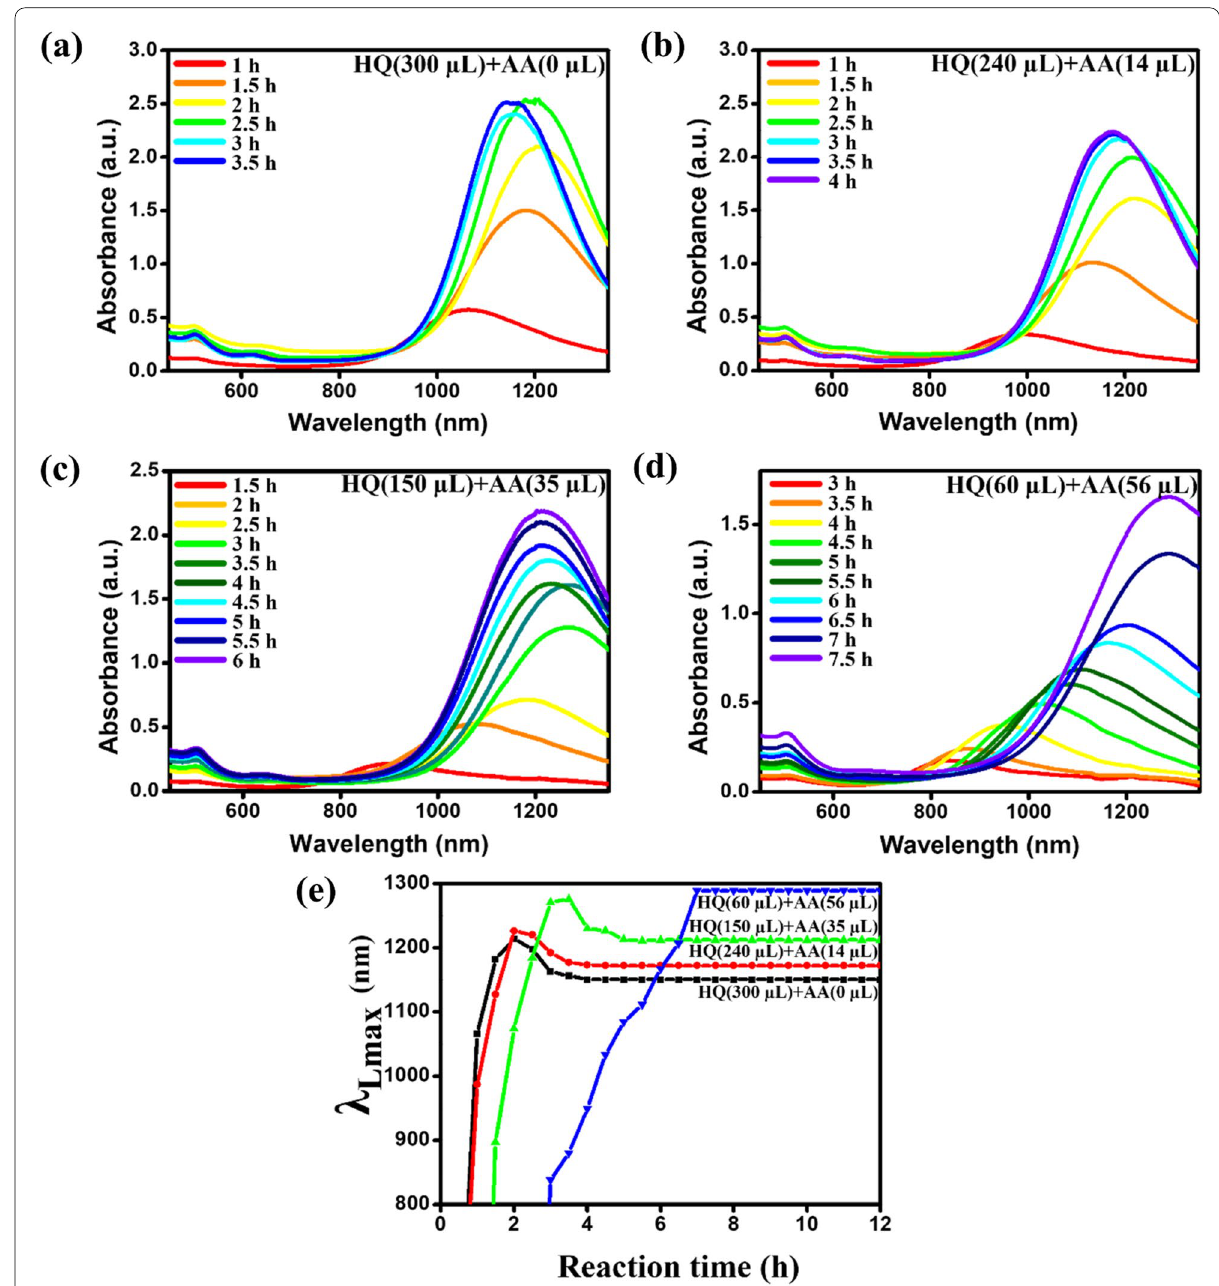
Fig. 6 Evolution of the UV–Vis-NIR absorbance spectrum of Au NRs during their growth when the volume of HQ and AA ratio was a HQ(300 µL) AA(0 µL), b HQ(240 µL) AA(14 µL), c HQ(150 µL) AA(28 µL), and d HQ(60 µL) + + + reaction